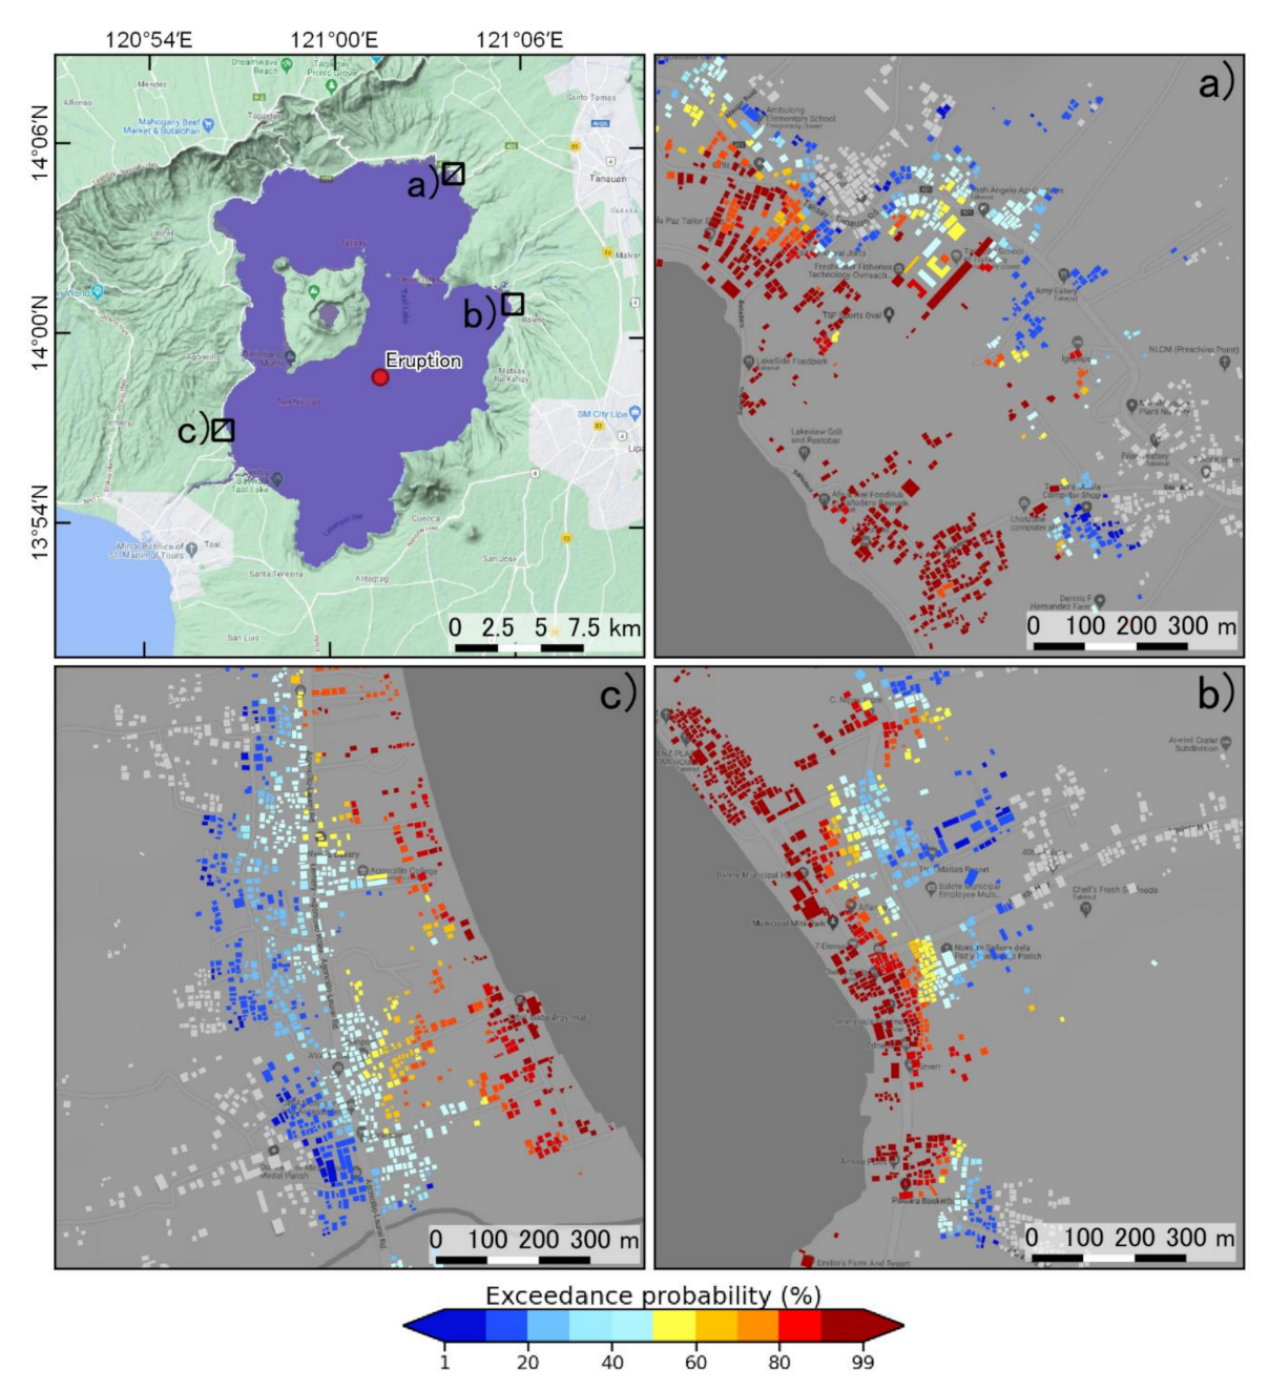
Figure 12. Probability of experiencing a tsunami inundation depth of more than 0.5 m in some example areas. ( a ) northern coastal area, ( b ) coastal area near to the eruption point, and ( c ) southern coastal